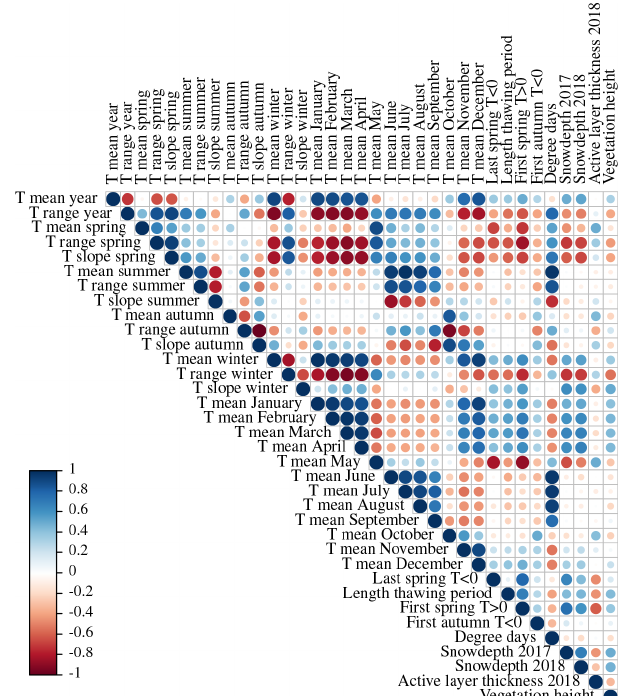
Figure 4. Pearson’s correlation coefficients ( R ) of all topsoil tem- perature characteristics ( ◦ C), active layer thickness (cm), and snow depth (cm) in the second period (September 2017 to August 2018).